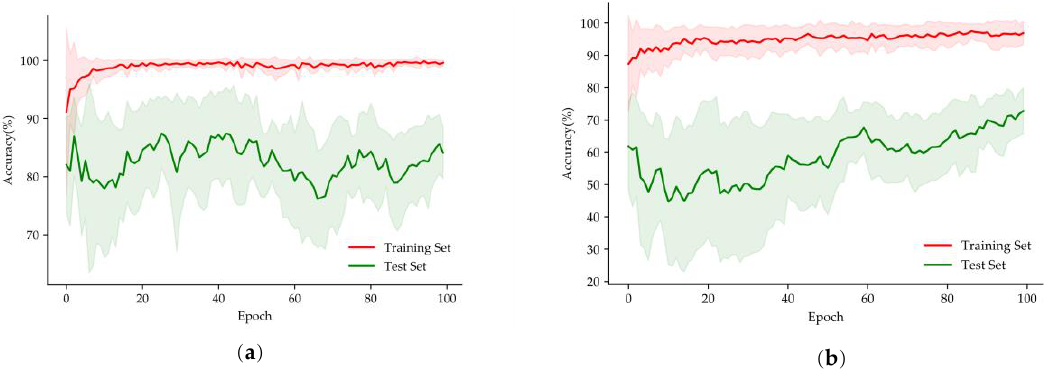
Figure 10. The change curve of accuracy during training by FCCDNNs. ( a ) C. elegans dataset, ( b ) zebrafish dataset.